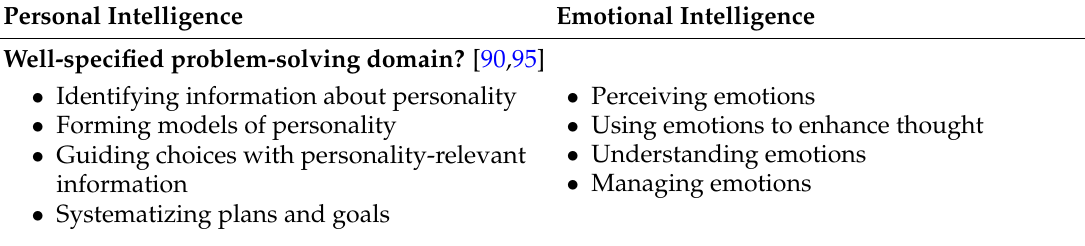
Table 1. Do the personal and emotional intelligence meet standard criteria for an